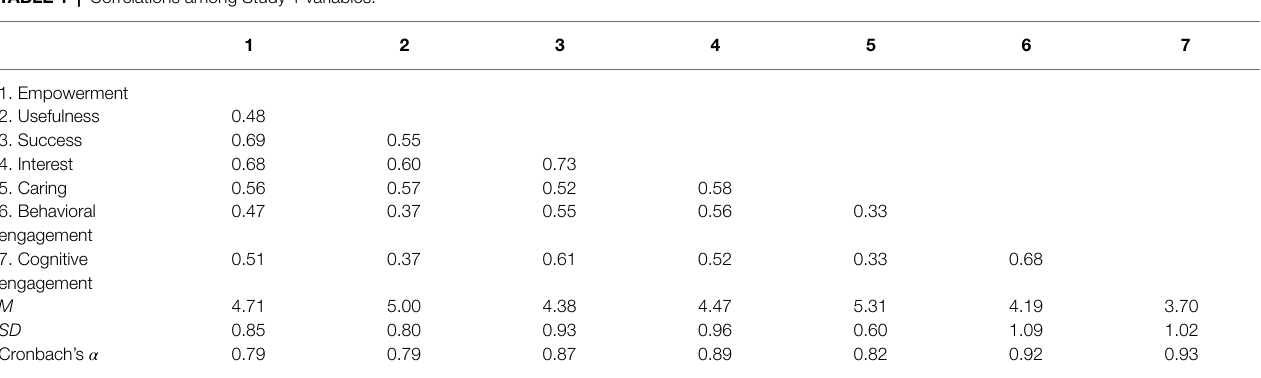
TABLE 1 | Correlations among Study 1